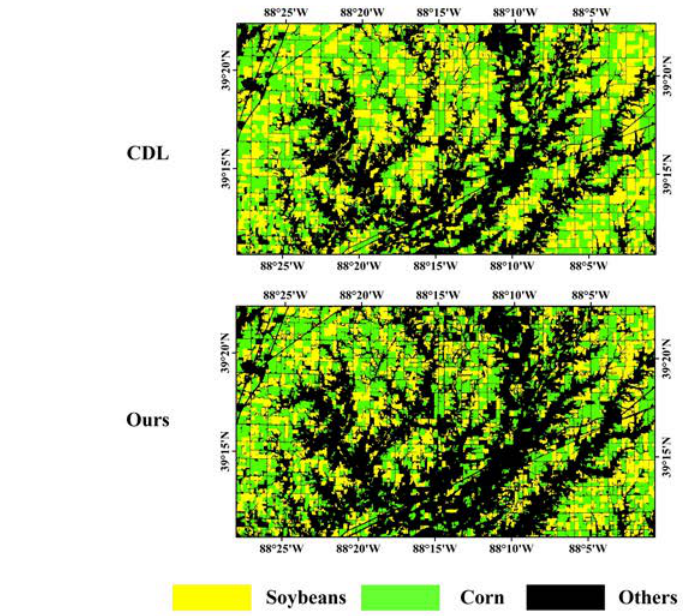
Figure 16. Soybean–corn distribution in Cumberland, Illinois, USA, in 2021 from CDL data and MACN. Table 6. Classification accuracy of MACN calculated from CDL data.